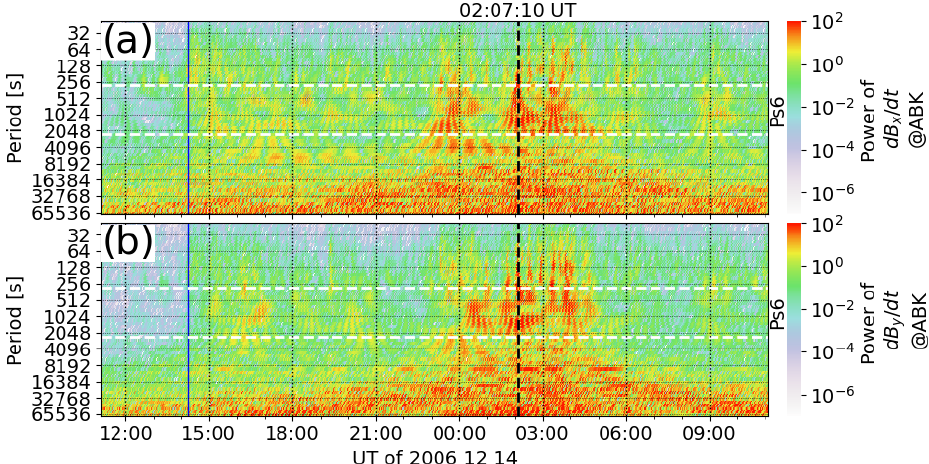
Figure 10. Wavelet transform of external d B x / d t and d B y / d t at KIR for the longer time interval from − 15 to + 9h of Fig. 9 compared to the ± 15min shown in Fig. 9i–j for the event on 15 December 2006 at 02:07:10UT. The period range of the ultra-low-frequency (ULF) pulsation class Ps6 (5–40min) (Jacobs et al., 1964) are shown with the horizontal dashed white lines. The vertical solid blue line indicates the SC at 14:14:18UT, and the vertical dashed black line indicates the time of the extreme external | d H / d t | observed at KIR. Table 4. Summary of the five studied events of the most intense external 10s | d H / d t | as observed by IMAGE between 1994 and 2018. UT MLT | d H / d t | Event type Ionospheric currents Possible driver [h] [nTs − 1 ] 2006 December 15 02:07:10 04 21.2 Substorm Undulating, intensified WEJ Magnetospheric fast flow? 2003 October 29 06:11:40–50 20.8 SC EEJ intensification & poleward motion Magnetopause compression 19.2 EEJ disruption by ULF waves Magnetopause expansion 18.0 Substorm Undulating, intensified WEJ Magnetospheric fast flow? 15.6 Substorm WEJ weakening & poleward retreat, ULF waves Transition region